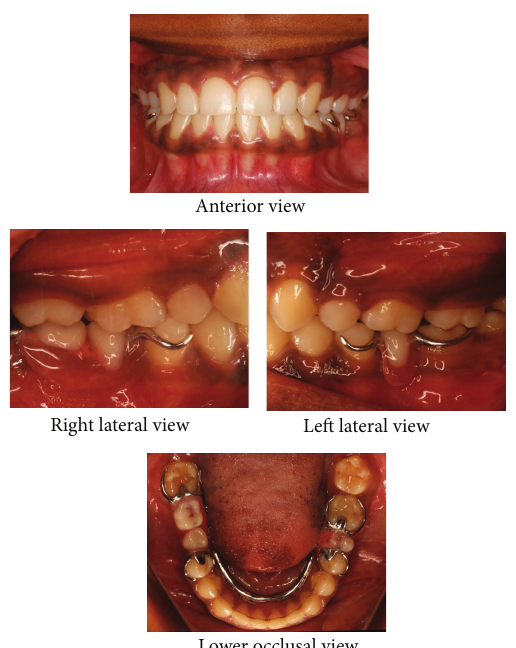
Figure 8: Posttreatment intraoral photographs: with removable cast partial denture.